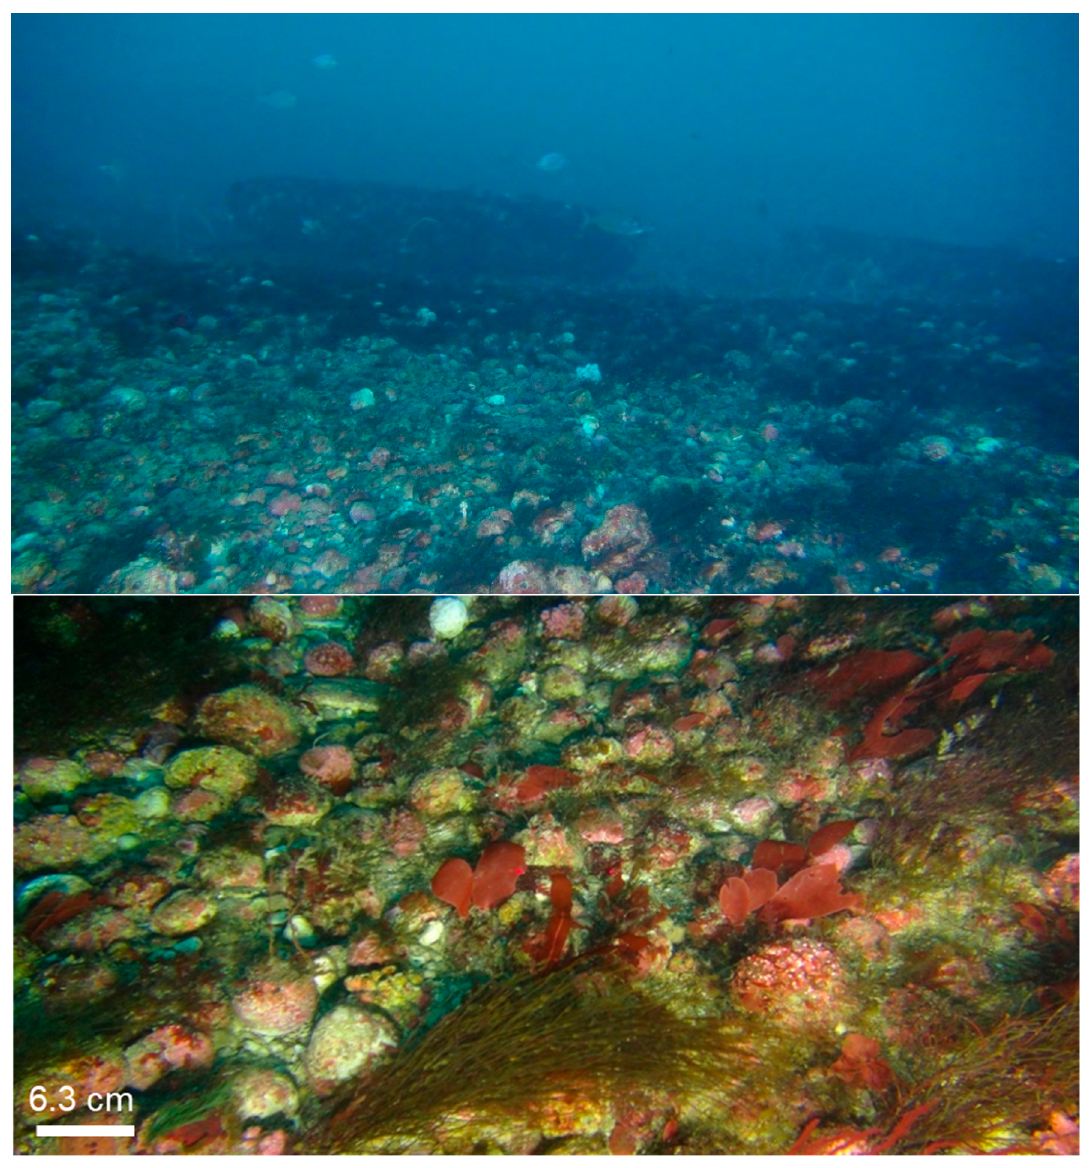
Figure 2. Remotely operated vehicle survey photographs collected during January/February 2017 of a rhodolith bed between 30 and 65 m depth off the Kei River mouth, South Africa.